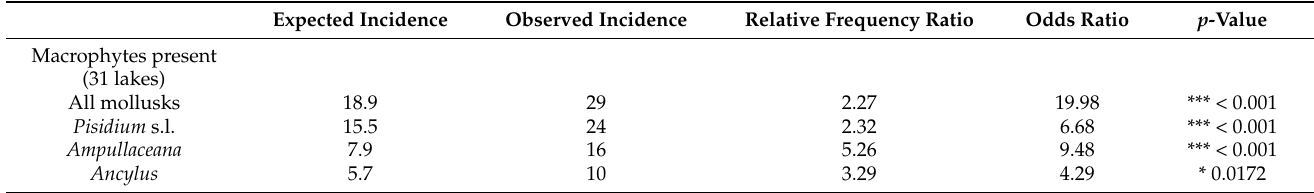
Table A3. Incidence (number of lakes) of Pisidium s.l., Ampullaceana , and Ancylus in relation to macrophyte and salmonid presence. Expected (null) incidence is the result of multiplying the relative frequency of occurrence of the variable and the overall incidence of the mollusk considered amongst the 82 lakes sampled. Relative frequency ratio refers to the ratio of the relative frequency of occurrence in lakes with the variable to that without the variable. Odds ratio (conditional maximum likelihood estimate) and significance ( p -value) refer to Fisher’s exact tests. Asterisks denote level of